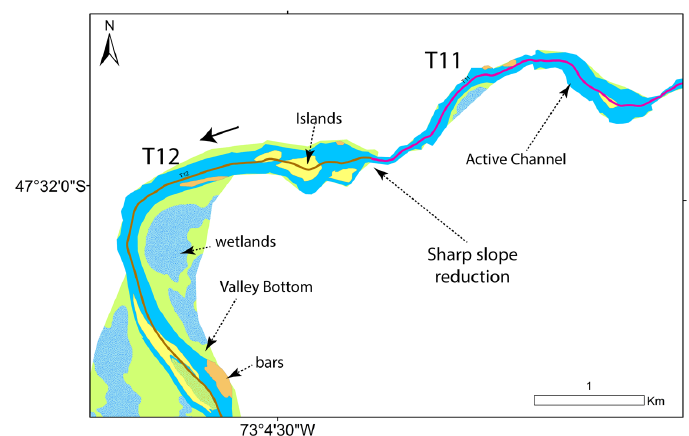
Figure 15. Baker case study. Example of typical coincidence of a reach boundary with a slope change and a VB narrowing (may be widening in other situations): end of segment D at km 100 approx. (Figure 12a). The longitudinal arrow indicates flow direction.